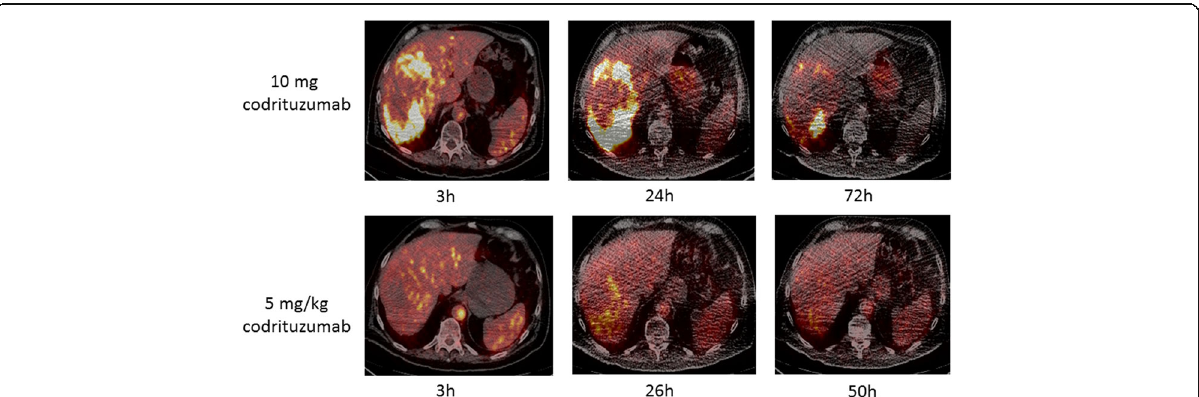
Fig. 4 Patient 7, serial-fused I-124 codrituzumab-PET/CT baseline images following injection of 190 MBq of I-124 codrituzumab (10 mg of codrituzumab) (upper panel). Upper panel images show prominent heterogeneous uptake in a large right liver tumor lesion, with more uptakes in the periphery than those in the central region. The lower panel shows serial-fused I-124 codrituzumab-PET/CT images obtained after treatment with sorafenib and codrituzumab (5 mg/kg) for 4 weeks and after injection of 183 MBq I-124 codrituzumab (co-infused with 5 mg/kg of codrituzumab). All images are displayed at the same SUV and show marked decrease in intensity of uptake in the periphery. For example, at 24 to 26 h, the SUVmax decreased in the cold co-infused images (lower panel) from 20 to 40% of the 10 mg injected mass, and in the periphery, there was less of a drop in SUVmax to 80 – 90% of the 10 mg injected mass, probably because of central